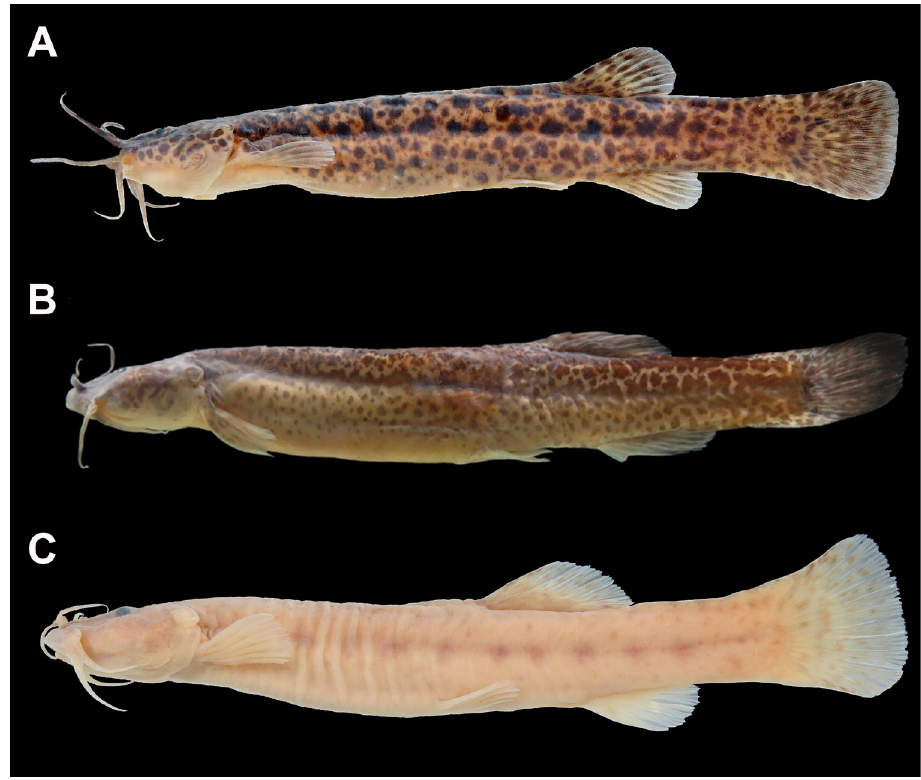
FIGURE 3 | A. Cambeva balios from Mampituba River basin, UFRGS 16295, 63.8 mm SL. B. Cambeva davisi from Ribeira de Iguape River basin, MZUEL 17202, 72.8 mm SL, fixed in alcohol. C. Cambeva iheringi